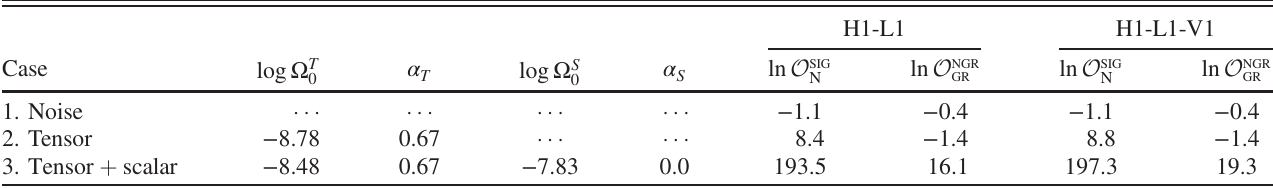
TABLE I. Stochastic background parameters used for each case study presented. For each case, the vector amplitude is set to zero. Also shown are the odds ratios computed for each simulated